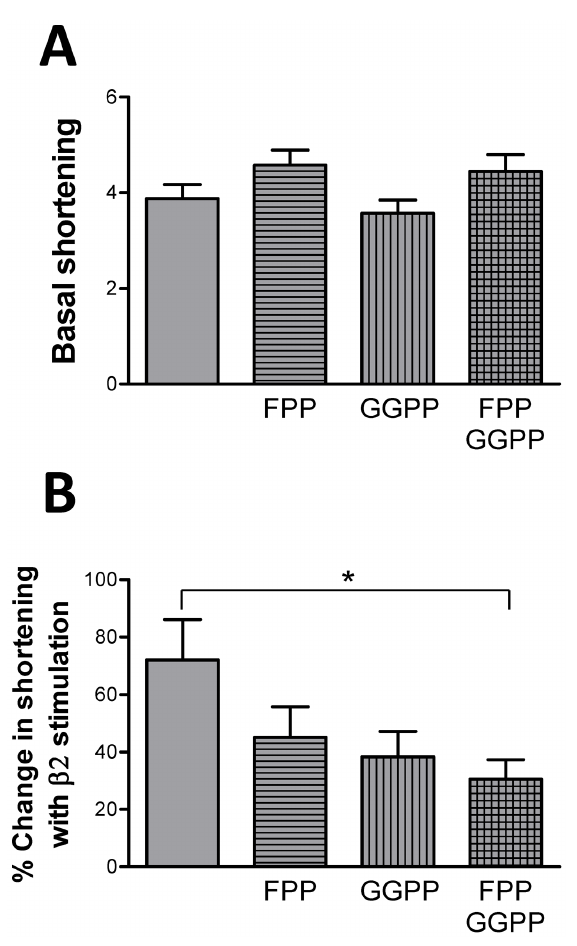
Figure 9. Isoprenoid dependence of simvastatin effects on basal function and the response to b 2-AR stimulation. Myocytes were cultured with simvastatin in the presence of farnesyl pyrophos- phate (FPP), and/or geranylgeranyl pyrophosphate (GGPP). A. Basal shortening (as a % of resting cell length). B. % change in shortening in response to b 2-AR stimulation with 100 nM zinterol plus 10 nM CGP20712A. n=32–38 myocytes from 7 hearts * P , 0.05, 1-way ANOVA.